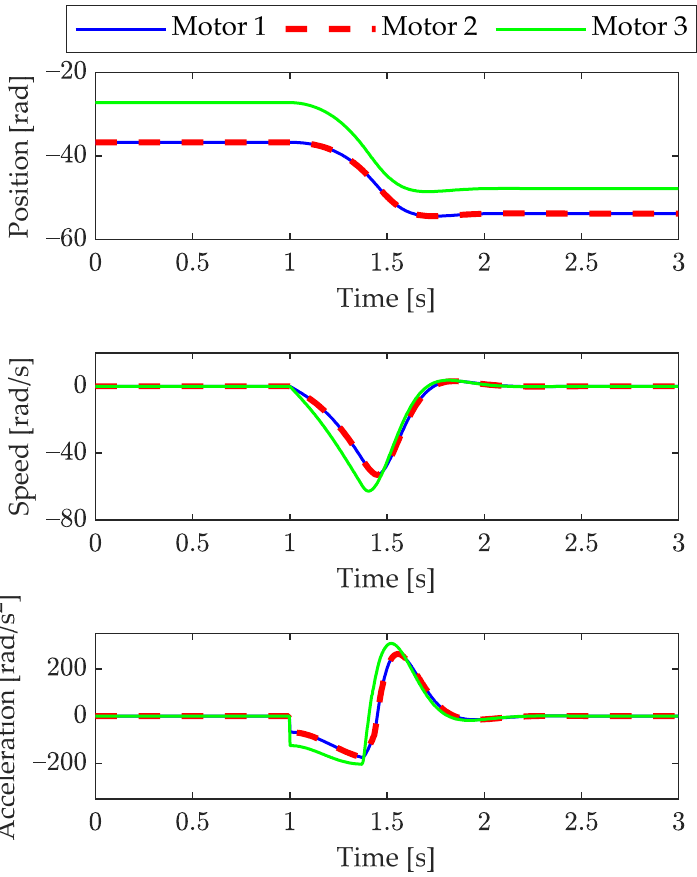
Figure 4. Time histories of the motors with the position step